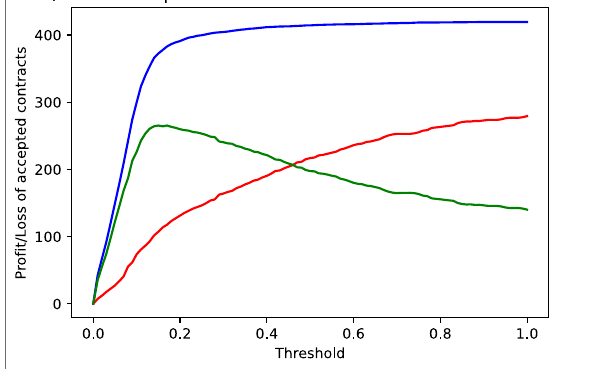
FIGURE5| Asafunction ofthechosenthreshold areshown the income by the accepted non-defaulting contracts (blue line), the loss incurred by the